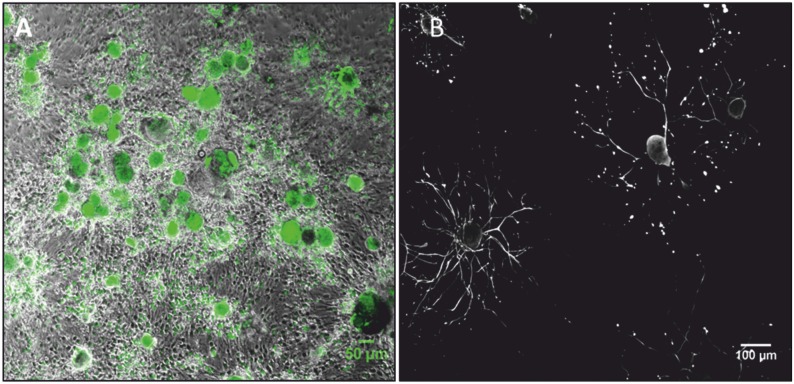
DRG neurons can be maintained in culture for extended periods.(A) Viable DRG neurons after 2 weeks in culture stained with calcein (green). (B) Diffuse neurite fragmentation in a neurofilament-positive neuron (*) at day 7. In the lower left a viable neurite bearing neuron is present.